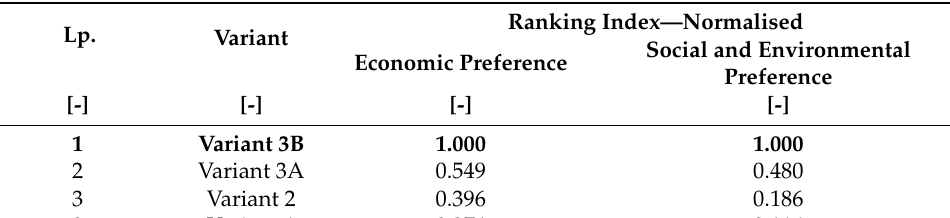
Table 13. Final ranking of variants—normalised.